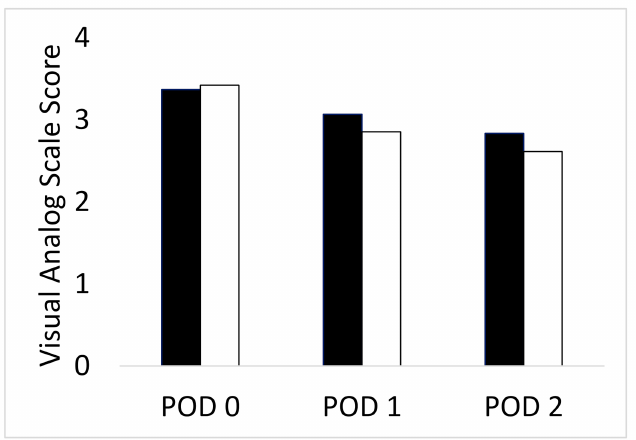
Figure 2. Average pain score on each post-operative day. Black bars = patient controlled analgesia; white bars = transversus abdominis plane block; POD = post-operative day.